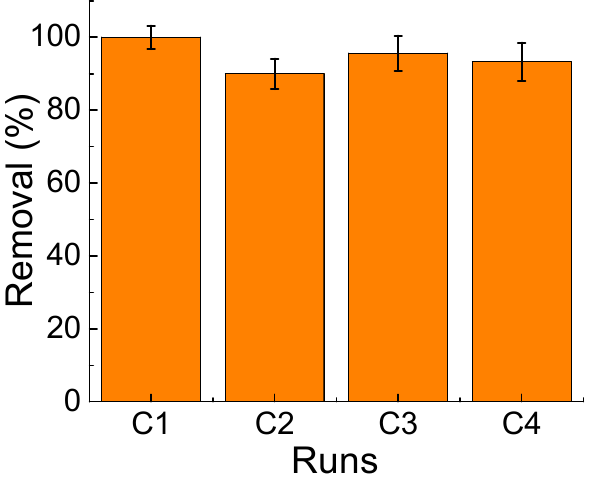
Figure 9. Reuse of a RVC electrode coated with magnetic nanoparticles using the A methodology, T = 25 °C, I = 100 mA.